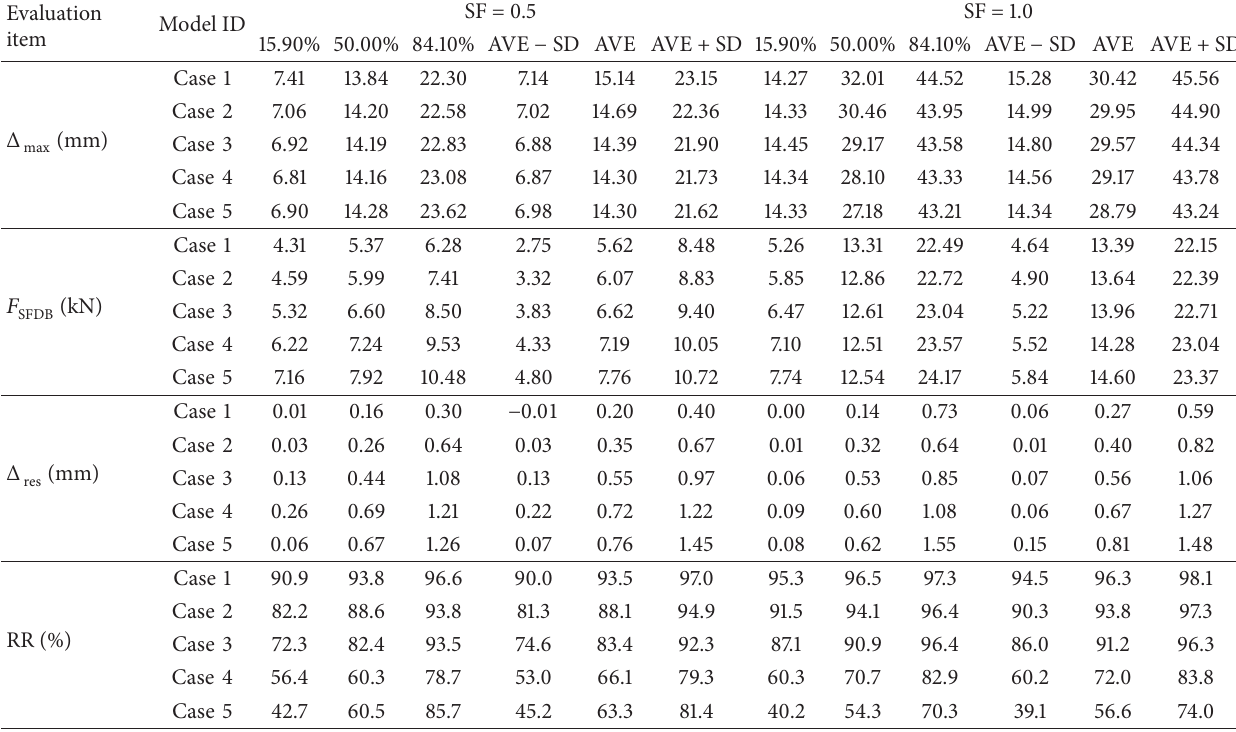
Table 5: Summary of statistical values for individual model cases under 2% in 50-year ground motions. Evaluation